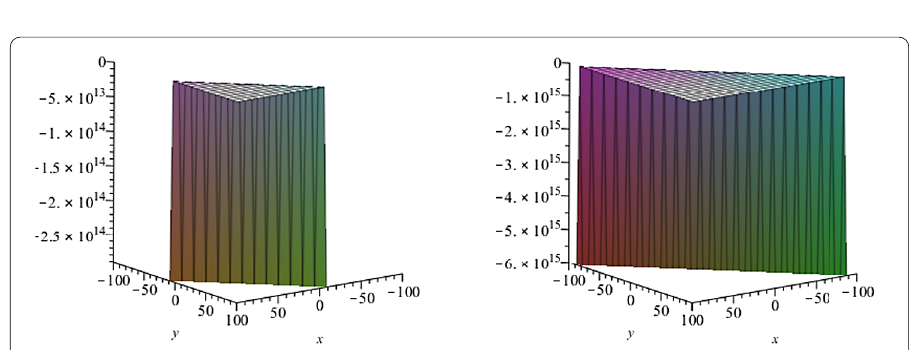
Figure 2 Solitary wave solution of Eq. (4.9) with β = 0.25 and β = 0.5, respectively, when λ = –1